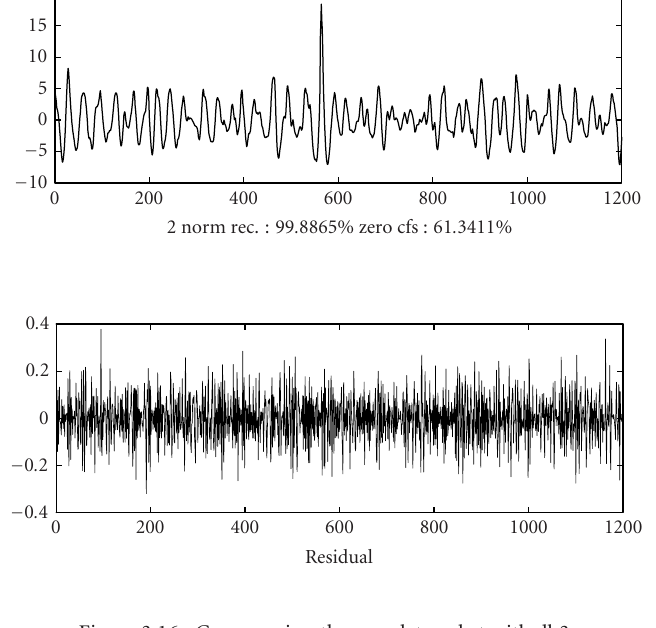
Figure 3.16. Compression thr. wavelet packet with db3.